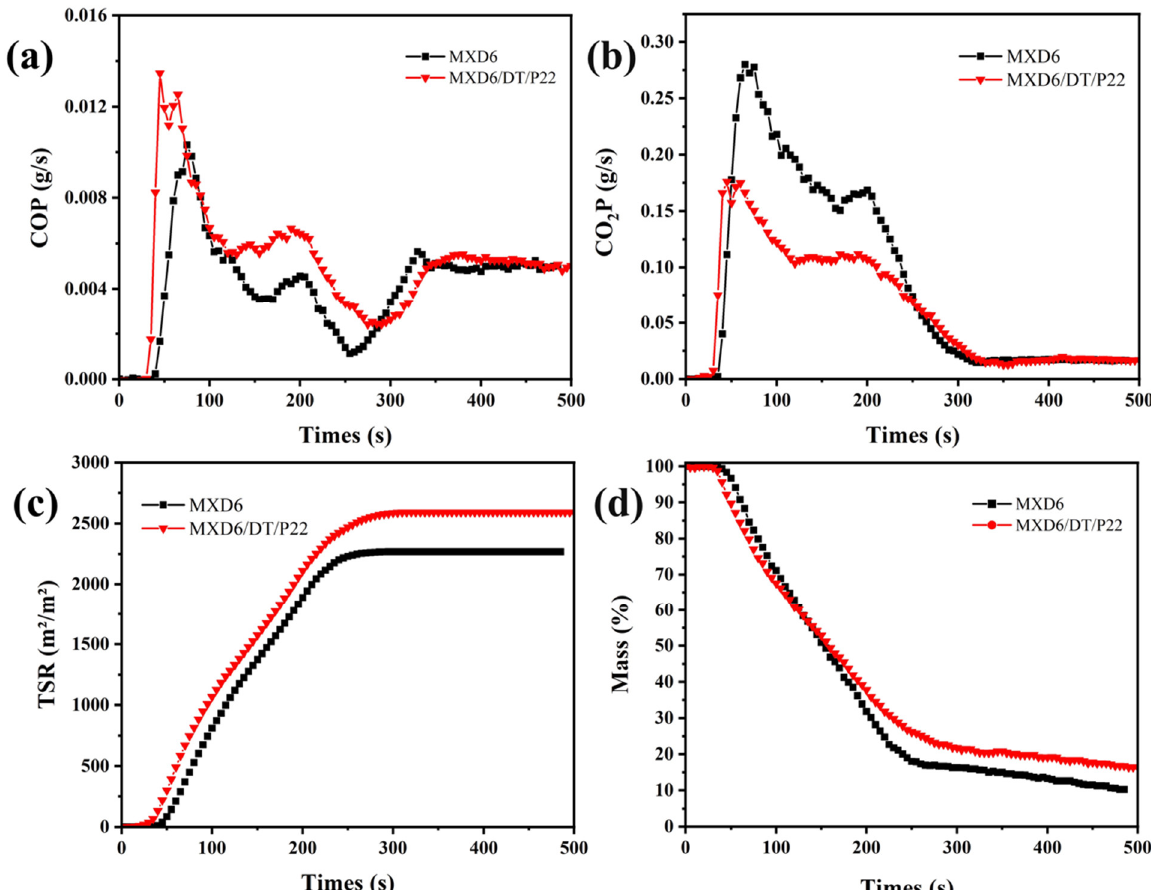
Figure 6. Rate of ( a ) CO release, ( b ) CO 2 release, ( c ) total smoke release and ( d ) mass loss curves during combustion in the CCT test of neat MXD6 and MXD6/DT/P22.